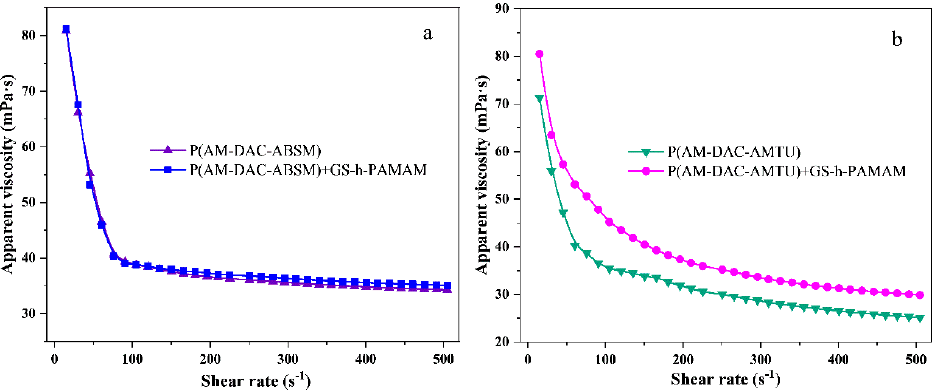
Figure 10. Shear thinning behavior of copolymers and compound systems: (a) P(AM-DAC-ABSM) and its supramolecular system; ( b ) P(AM-DAC-AMTU) and its supramolecular and its supramolecular system; (b) P(AM-DAC-AMTU) and its supramolecular system.